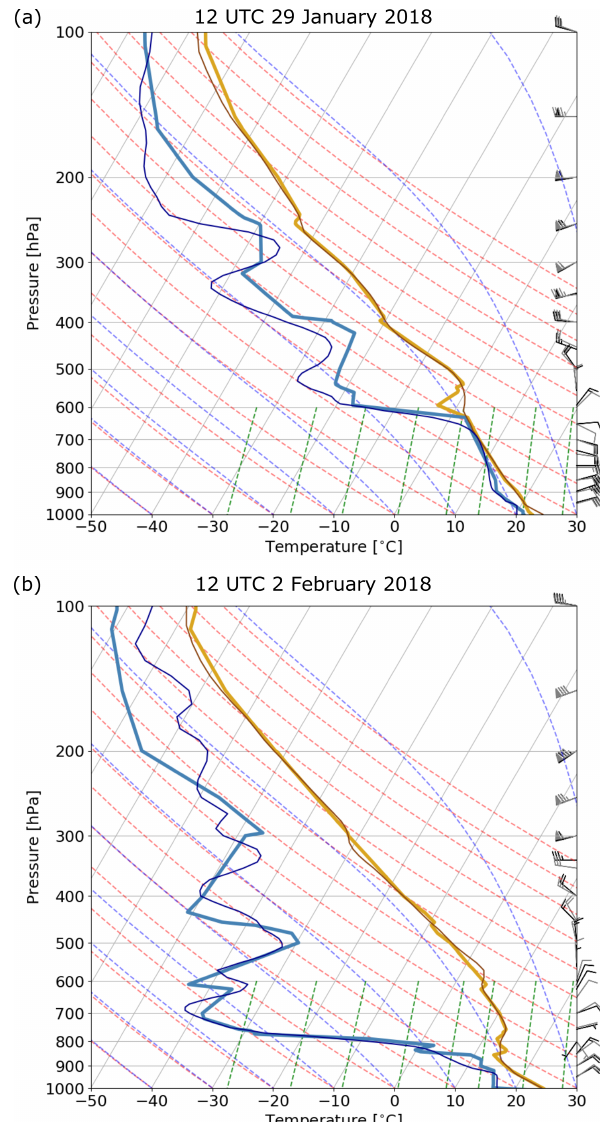
Figure 9. Vertical soundings from Barbados Grantley Adams Air- port at (a) 12:00UTC on 29 January 2018 (extratropical trade wind regime) and (b) at 12:00UTC on 2 February 2018 (extratropical dry intrusion regime). The skew- T log- p diagrams show temperature (brown lines) and dew point temperature (blue lines). The measured soundings are shown by thick lines; pseudo-soundings from ERA5 data are shown by the thin lines for comparison. The measured hor- izontal wind is shown by the wind barbs on the right-hand side of the diagrams in black, and the winds from the pseudo-sounding are shown by grey wind